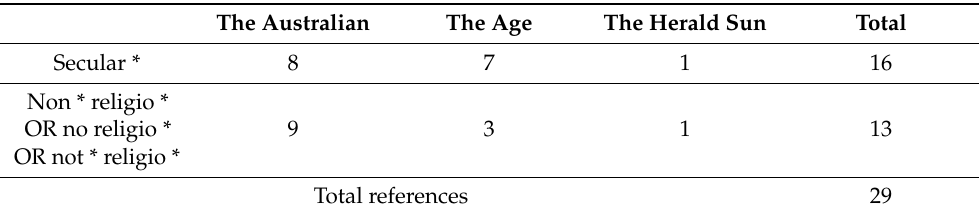
Table 12. Secular Sacred—references across the